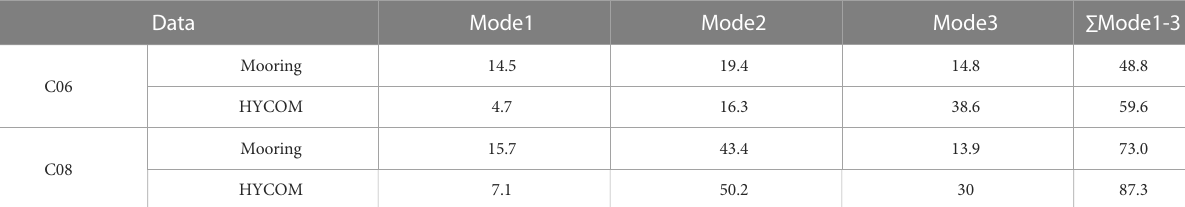
TABLE 2 Percentage of different modes.